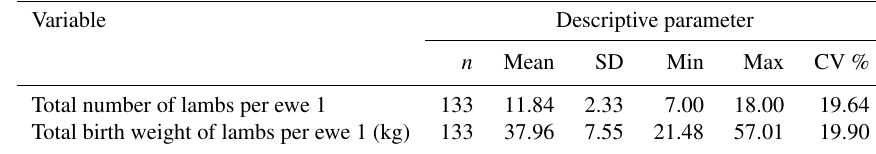
Table 1. Descriptive statistics for the total number of lambs per ewe 1 and total birth weight of lambs per ewe 1. Variable Descriptive parameter